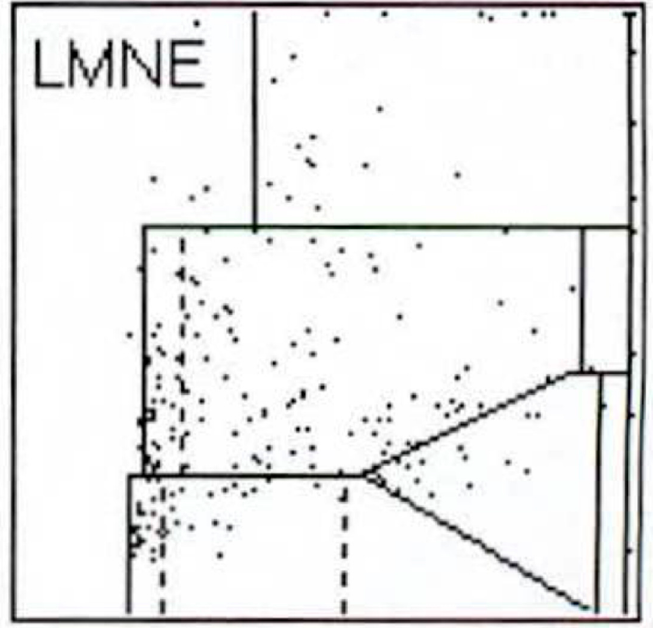
Figure 5. LMNE matrix of a type III (combined type) with one cloud in the area of the neutrophil leukocytes and a second cloud in the NOISE area in a 76 ‐ year ‐ old male patient with a peripros ‐ thetic joint infection of a total knee arthroplasty. The measured cell count was 5840 cells/ μ L.